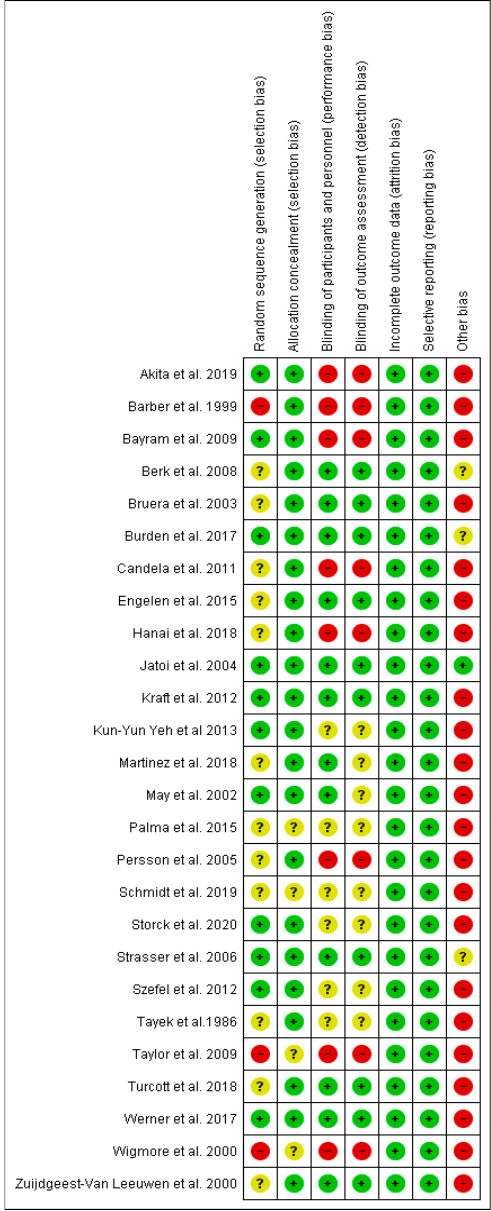
Figure 3. Risk of bias summary: review authors’ judgments about each risk of bias item for each included study.